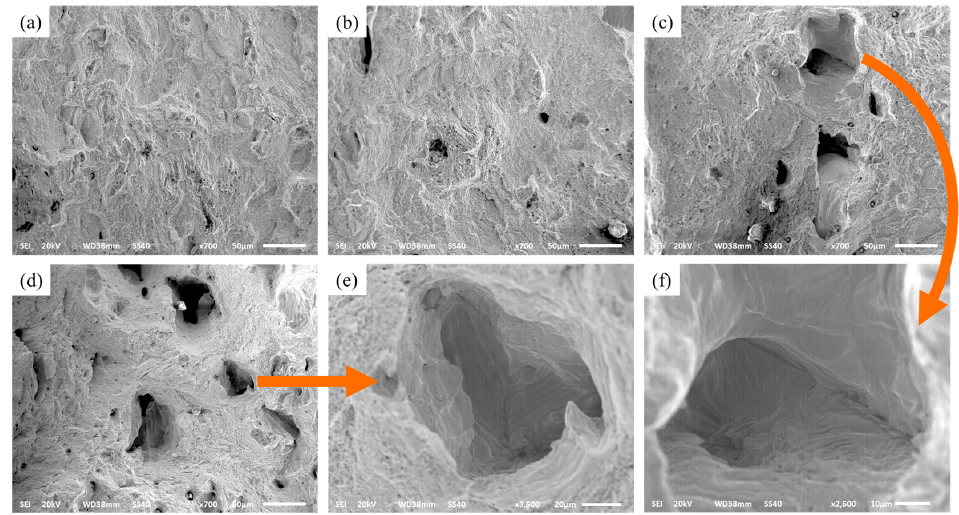
Figure 13. Morphology of tensile fracture surface ( a ) exposure time of 80 μ s; ( b ) exposure time of 120 μ s; ( c ) exposure time of 160 μ s; ( d ) exposure time of 200 μ s; ( e ) local enlarged image of coarse dimple rupture of (d); ( f ) local enlarged image of coarse dimple rupture of (c).